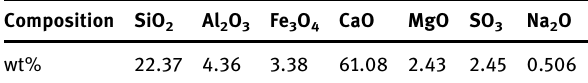
Table 1: Chemical composition of cement